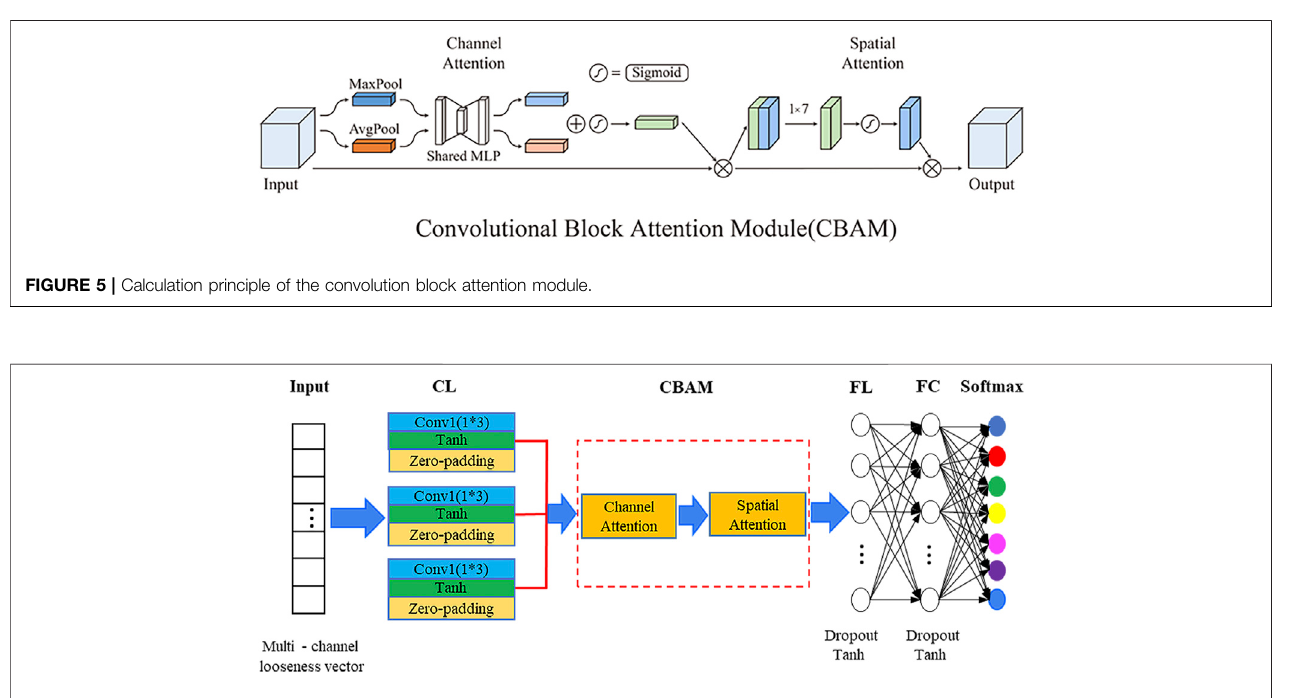
FIGURE 6 | Architecture diagram of the CBAMCNN